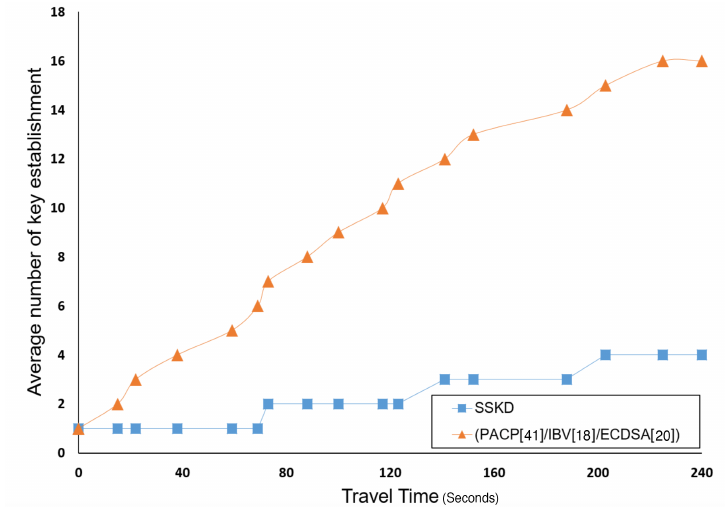
Figure 5. Average number of key